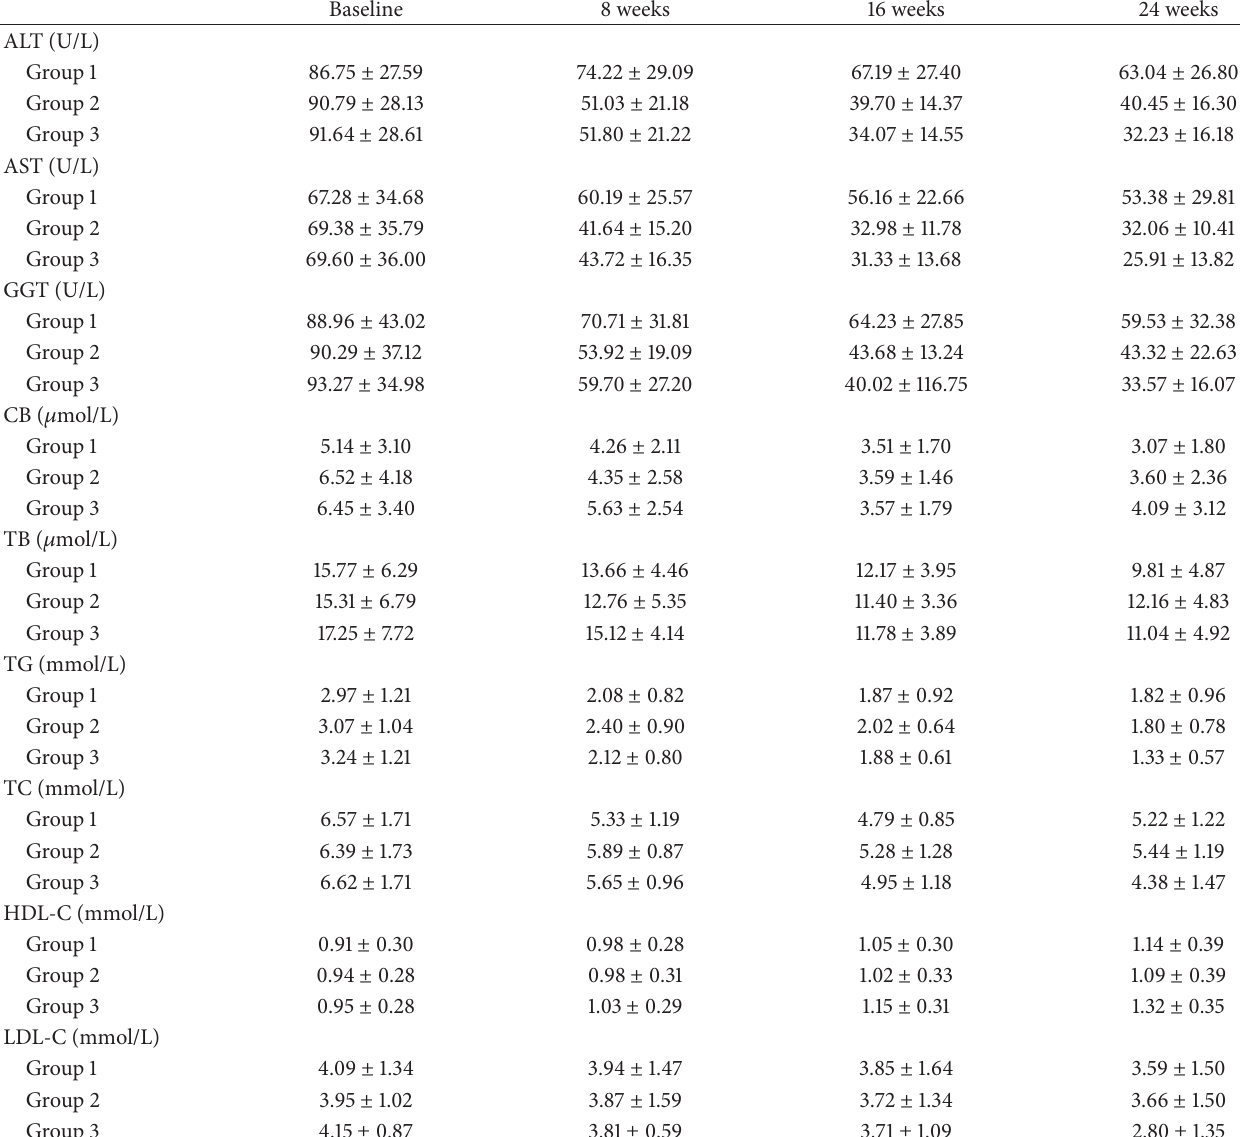
Table 4: Liver function and lipid Profile in the three groups at baseline and during treatment. Baseline 8